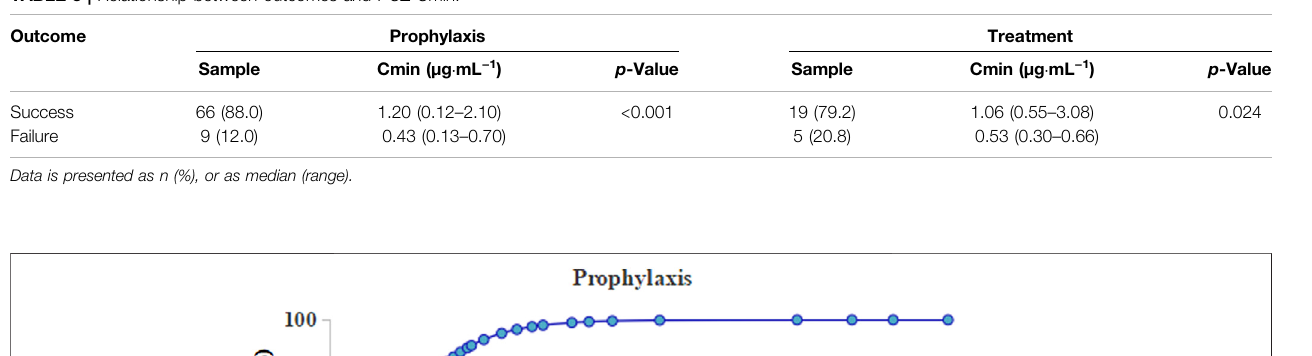
Frontiers in Pharmacology |